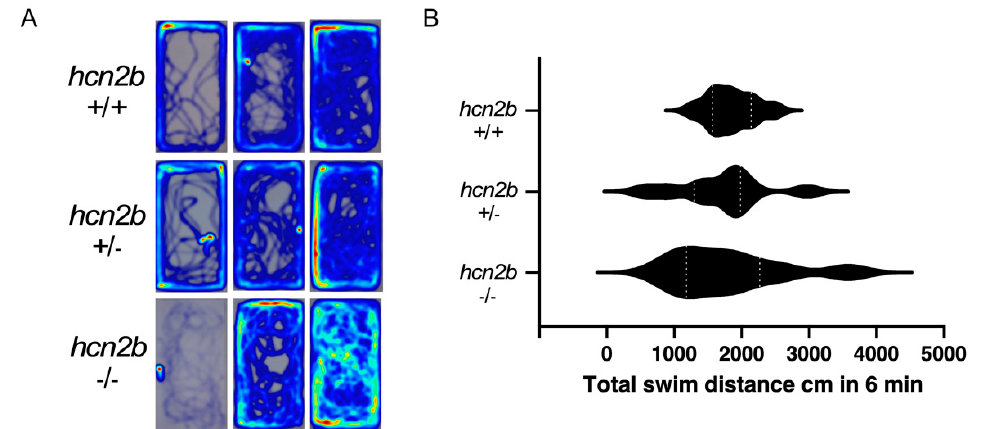
Figure 6. Novel tank diving assay. ( A ) Heat maps of three samples (low, medium and high activity) of the WT, hetero- and homozygous hcn2b zebrafish mutants in the swimming performance for six minutes in the novel tank. ( B ) Total swimming distances of the WT, hetero- and homozygous hcn2b zebrafish mutants. No statistical differences were observed between groups but hcn2b − / − displayed heterogeneous values that corresponded with moments of hyperactivity and immobility. The heat maps and swimming distances were analyzed using EthoVisionXT (Noldus IT, Wageningen, The Netherlands).